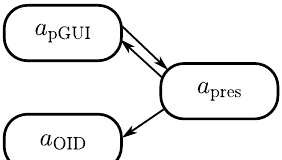
Figure 16. Structure of the presentation module.